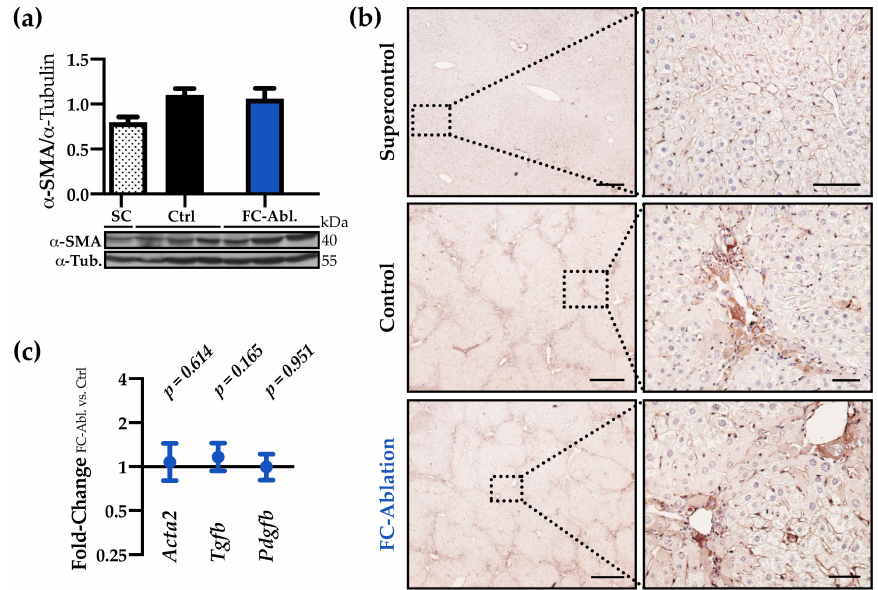
Figure 3. The antifibrotic e ff ect was not accompanied by a reduction of myofibroblasts. ( a ) Western blot analysis and optical densitometry thereof revealed that the hepatic α -SMA levels were increased following TAA-treatment but unchanged by fibrocyte ablation. Two individual western blots were included in the analysis, a representative blot is shown. Arbitrary unit. SC n = 2; Ctrl, FC-Abl. n = 6. Mean + SEM is depicted. ( b ) Immunohistochemical staining of α -SMA (brown) demonstrated the periportal accumulation of myofibroblasts in TAA-treated animals and an unchanged expression pattern in result of the fibrocyte ablation. Representative stainings are shown. Magnification 40 × and 200 × , bars 400 and 50 µ m. ( c ) Hepatic gene expression levels of Acta2 , Tgfb, and Pdgfb were comparable at the end of the experiment (full data in Figure